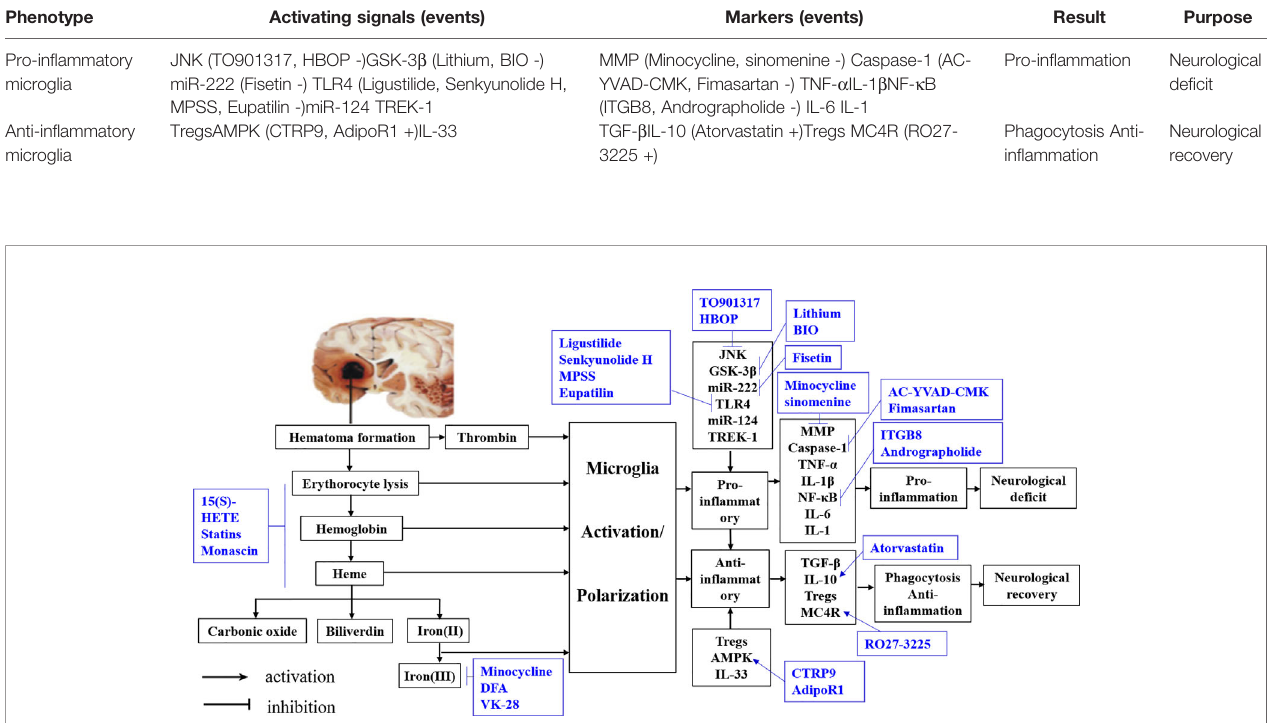
FIGURE 4 | Summary of interventions for ICH targeting microglial polarization. Available intervention strategies are labeled